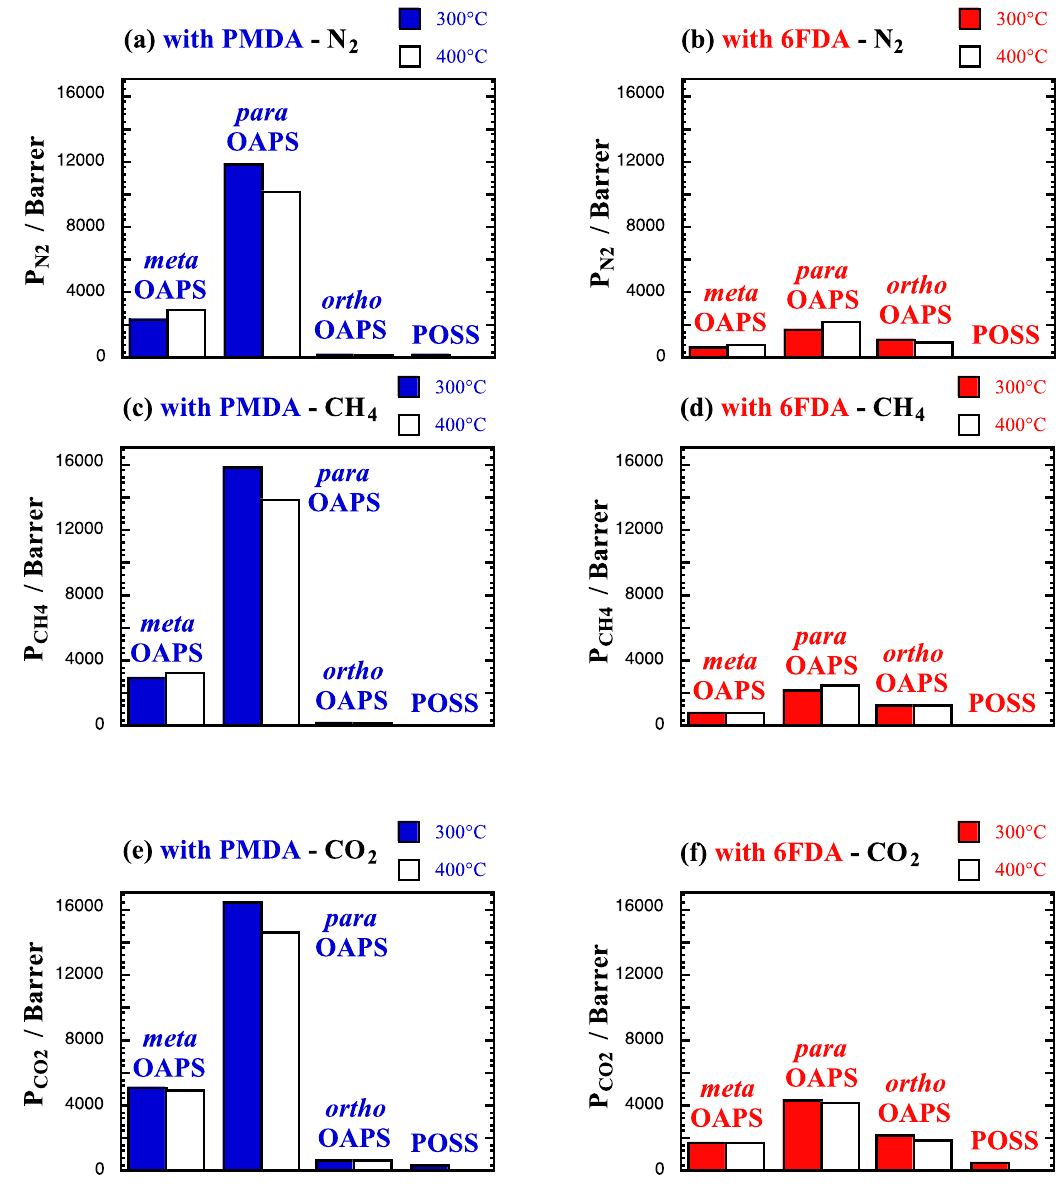
Figure 7. Single-gas permeability coefficients P gas at 300 °C and 400 °C in the PMDA and 6FDA polyOAPS/POSS-imides for ( a , b ) N 2 , ( c , d ) CH 4 and ( e , f ) CO 2 feeds at 60 bar. The maximum standard error is 470 Barrer for the PMDA networks and 180 Barrer for the 6FDA networks. For POSS, P N2 and P CH4 are of the order of 80 – 100 Barrer at 300 °C, and as such, are difficult to observe on the scale of Figure 7.